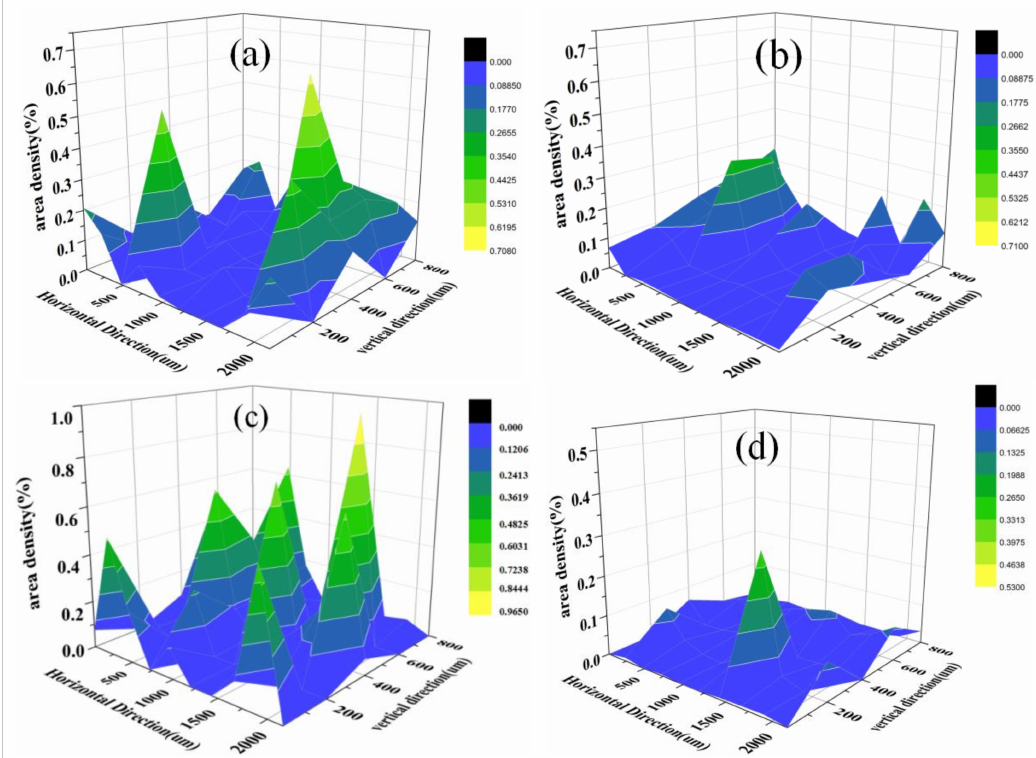
Figure 5. The variation of inclusion area density distribution in H08A welding rod steel treated with calcium: ( a , b ) for inclusion area density distribution before and after calcium treatment of steel A; and ( c , d ) for inclusion area density distribution before and after calcium treatment of steel